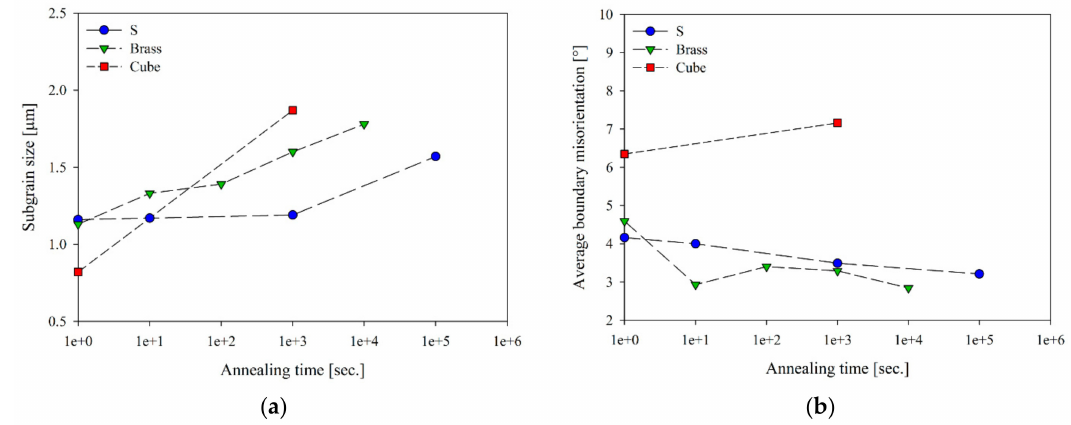
Figure 6. Subgrain growth ( a ) and evolution of average boundary misorientations ( b ) during annealing of Al-0.25Mn at 275 ◦